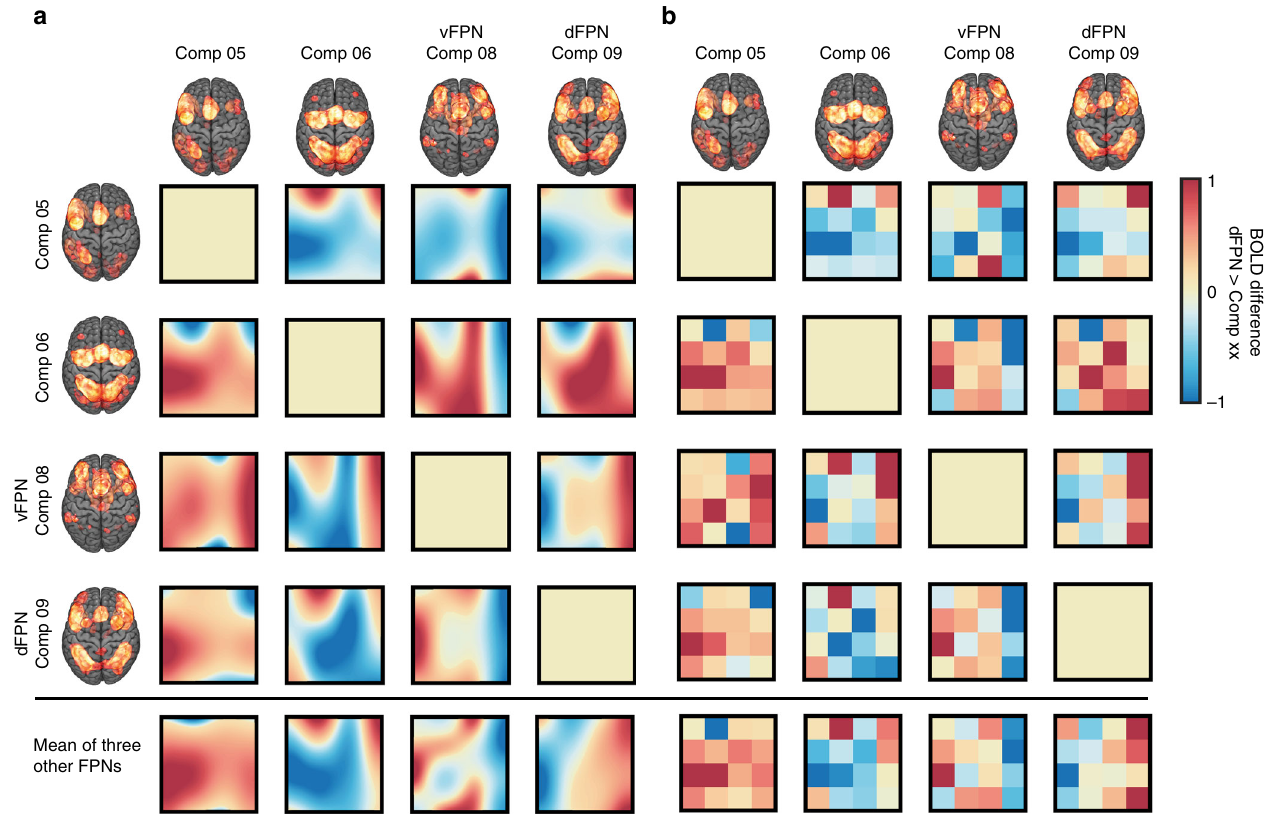
Fig. 6 Post-hoc pairwise comparison between all four FPNs. a Group-level Bayesian predictions (i.e., Gaussian process regression) based on pairwise differences in BOLD between each pair of FPNs (i.e., Components (Comp) from the meta-analysis). b To explore if the Gaussian process regression resulted in sensible predictions, we also plotted the mean differences in BOLD between each pair of FPNs across all subjects for each cell in the task space. Data is pooled from both Experiment 1 and Experiment 3. In the bottom row, we show results for the same target measure we used in Experiment 3: difference in BOLD between each single FPN and the mean of the remaining three FPNs. Our results demonstrate the existence of a complex many-to- many mapping between cognitive tasks and FPNs as not a single task, but instead a functional pro fi le across many tasks (i.e., the whole task space) is unique to the dFPN and